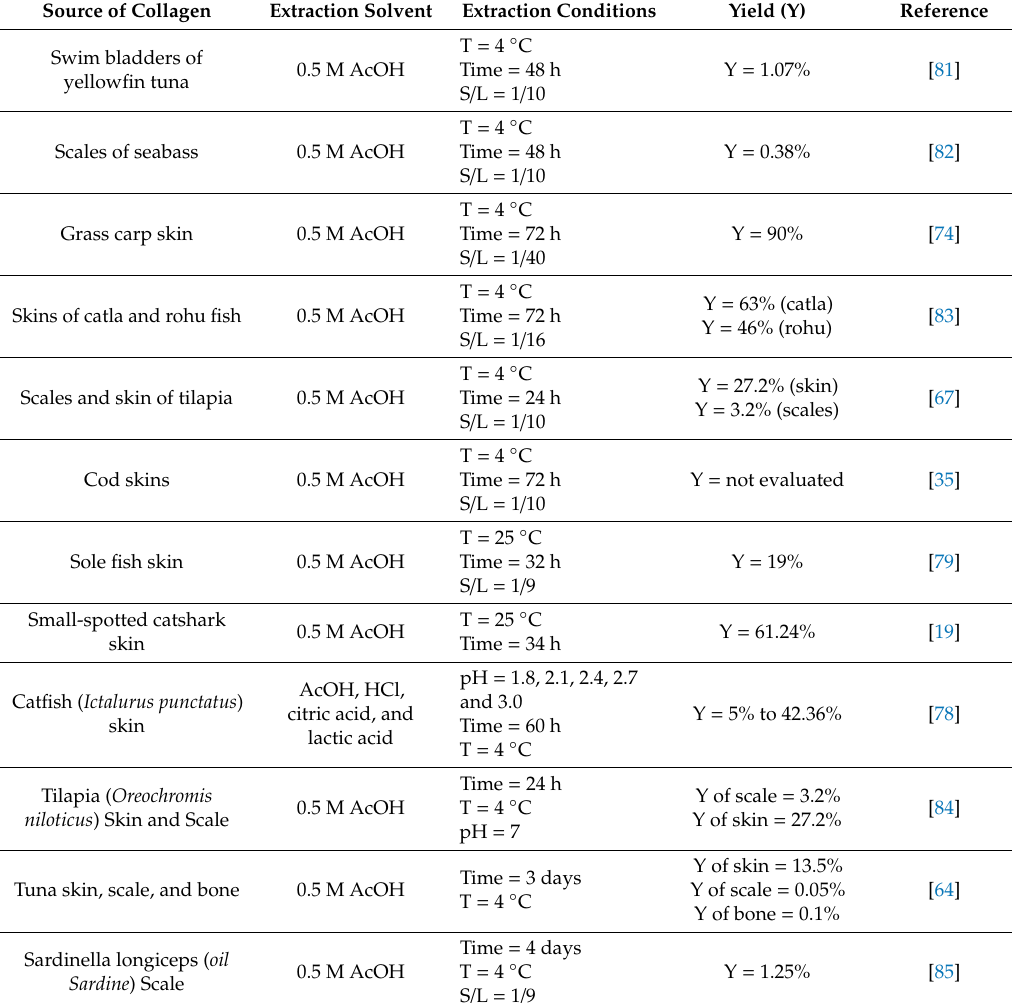
Table 2. Summary of the experimental conditions employed for fish collagen isolation using AcOH